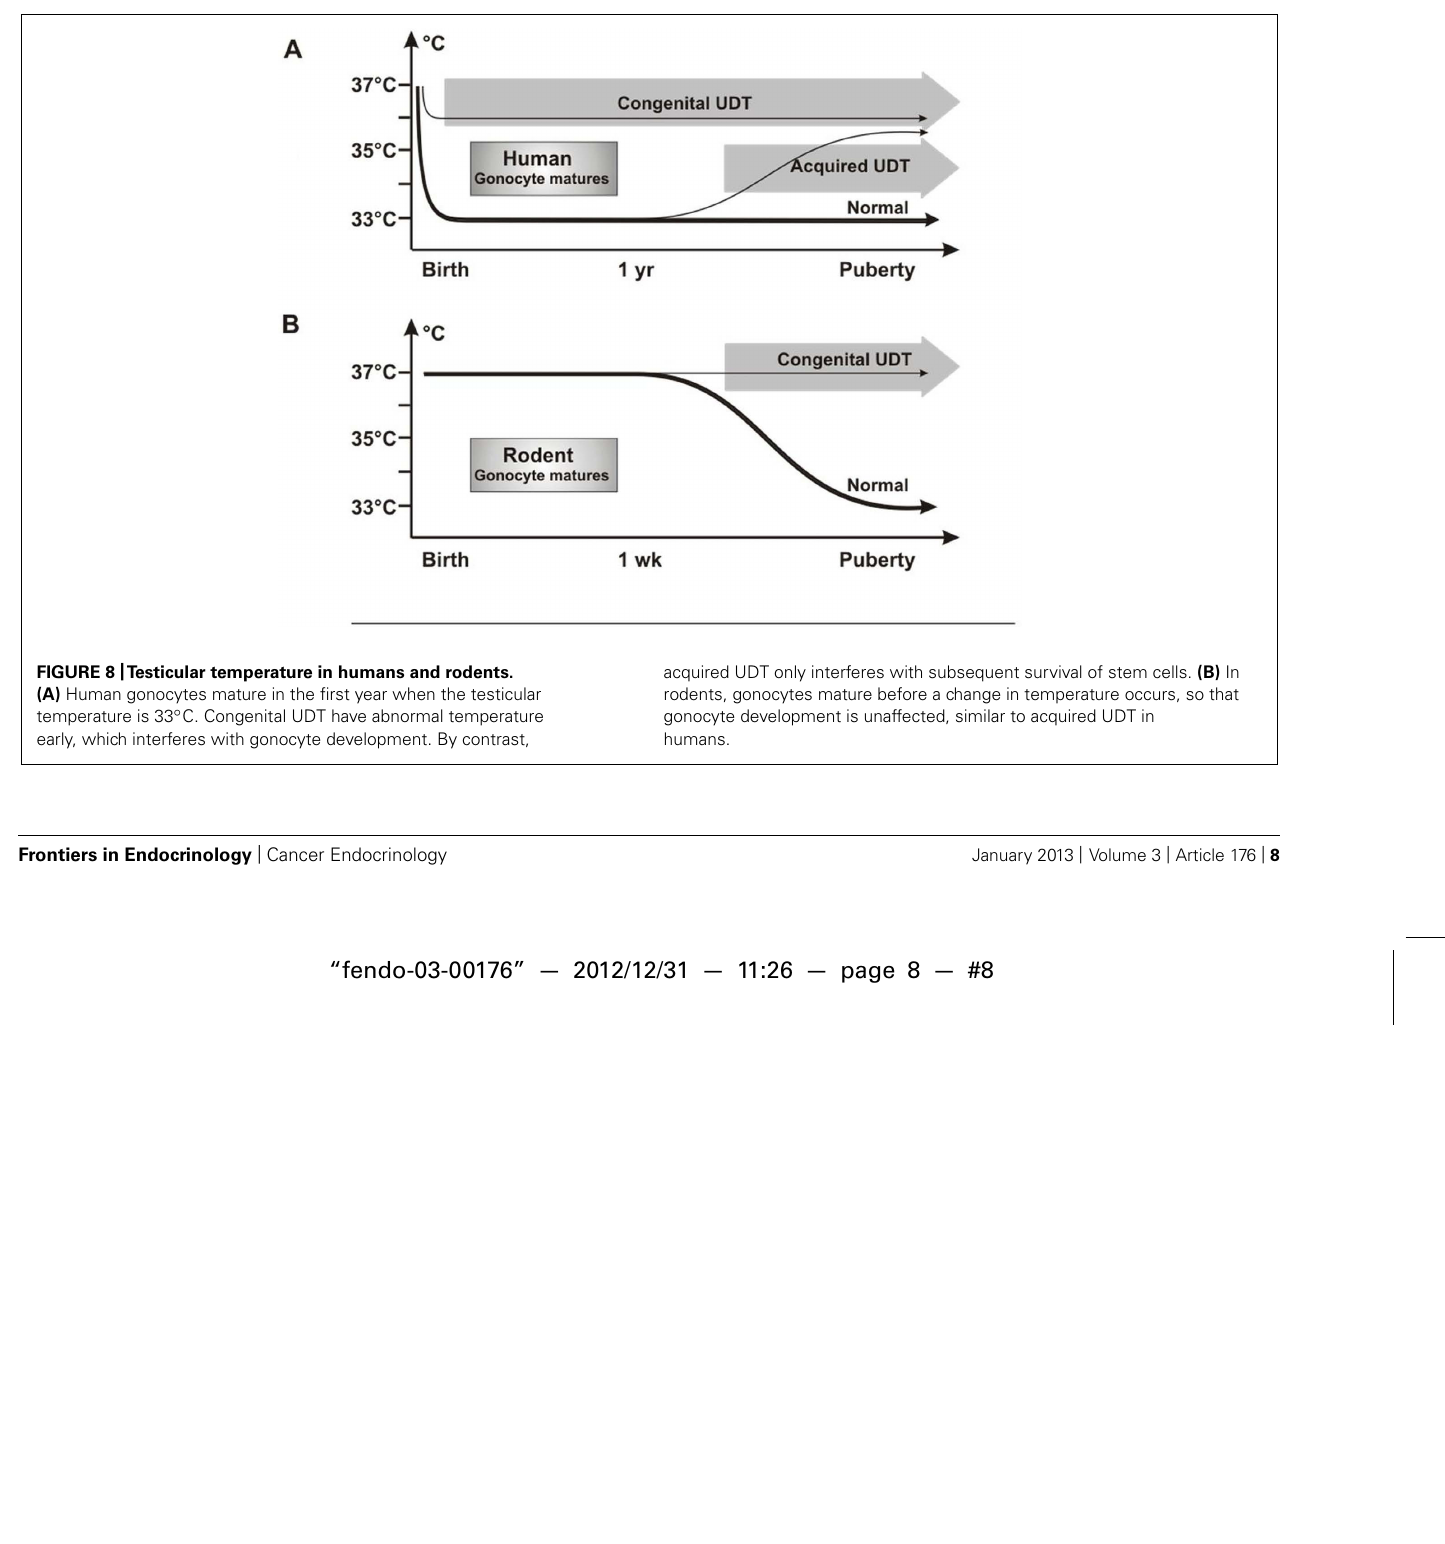
FIGURE 8 |Testicular temperature in humans and rodents. (A) Human gonocytes mature in the first year when the testicular temperature is 33 ◦ C. Congenital UDT have abnormal temperature early, which interferes with gonocyte development. By contrast,